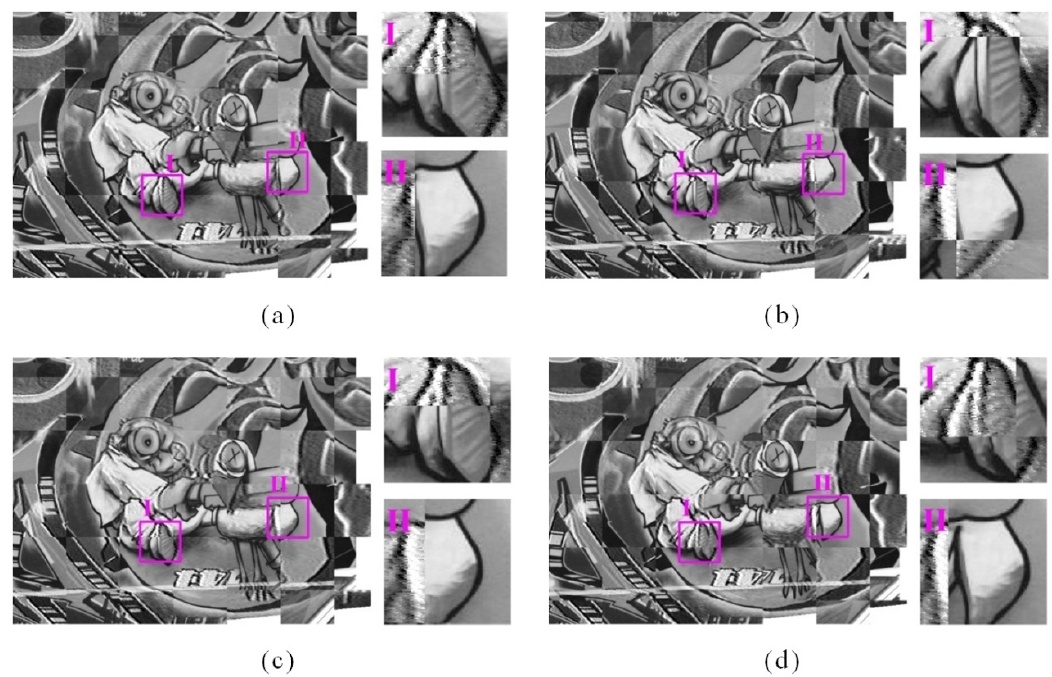
Figure 12. ( a )–( f ) Red points show the matching results of the Mata’s method with groups of stereo images. The yellow lines represent the epipolar lines estimated from matching points.